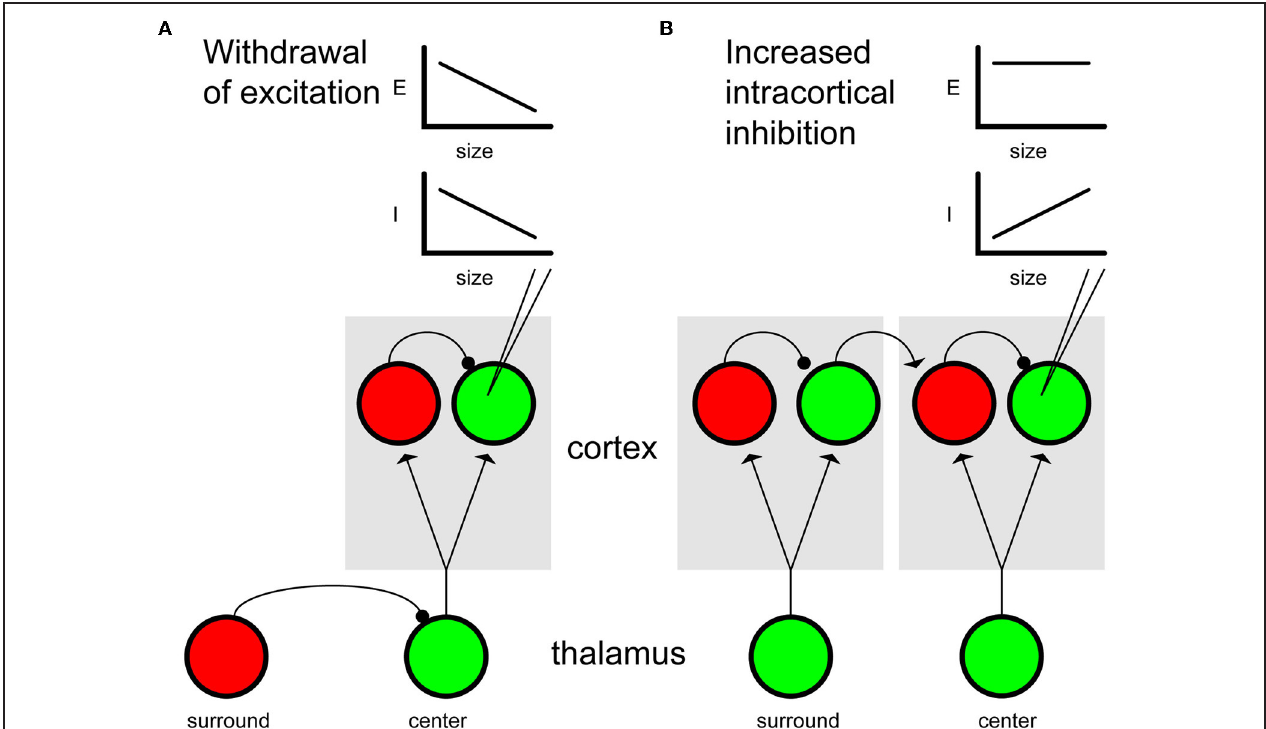
FIGURE 1 | Mechanisms of surround suppression. (A) Withdrawal of excitation. During center-only stimulation, thalamocortical feed-forward projections target both excitatory (green) and inhibitory (red) cortical neurons, leading to both excitation and inhibition. Increasing the spatial extent of the stimulus recruits inhibitory intrathalamic connections resulting in a net reduction of feed-forward drive to cortex. Because drive is reduced to both pyramidal cells and interneurons, withdrawal of excitation ultimately leads to a balanced decrease in both excitatory (E) and inhibitory (I) conductance in pyramidal neurons (inset plots represent conductances recorded from the